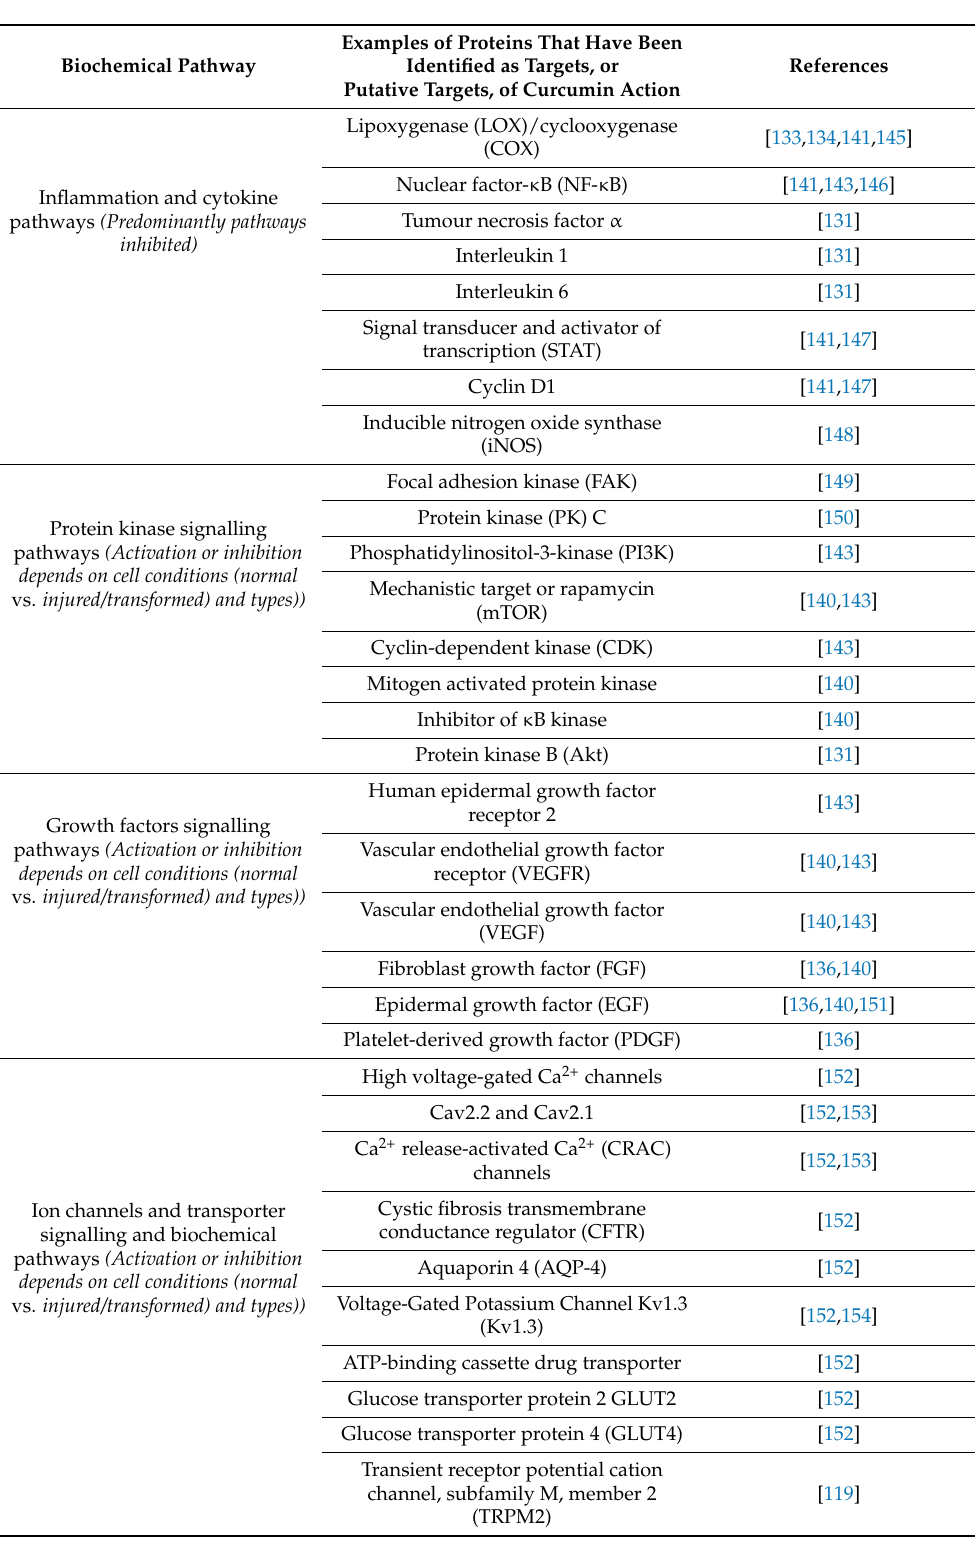
Table 2. Cont . Biochemical Pathway